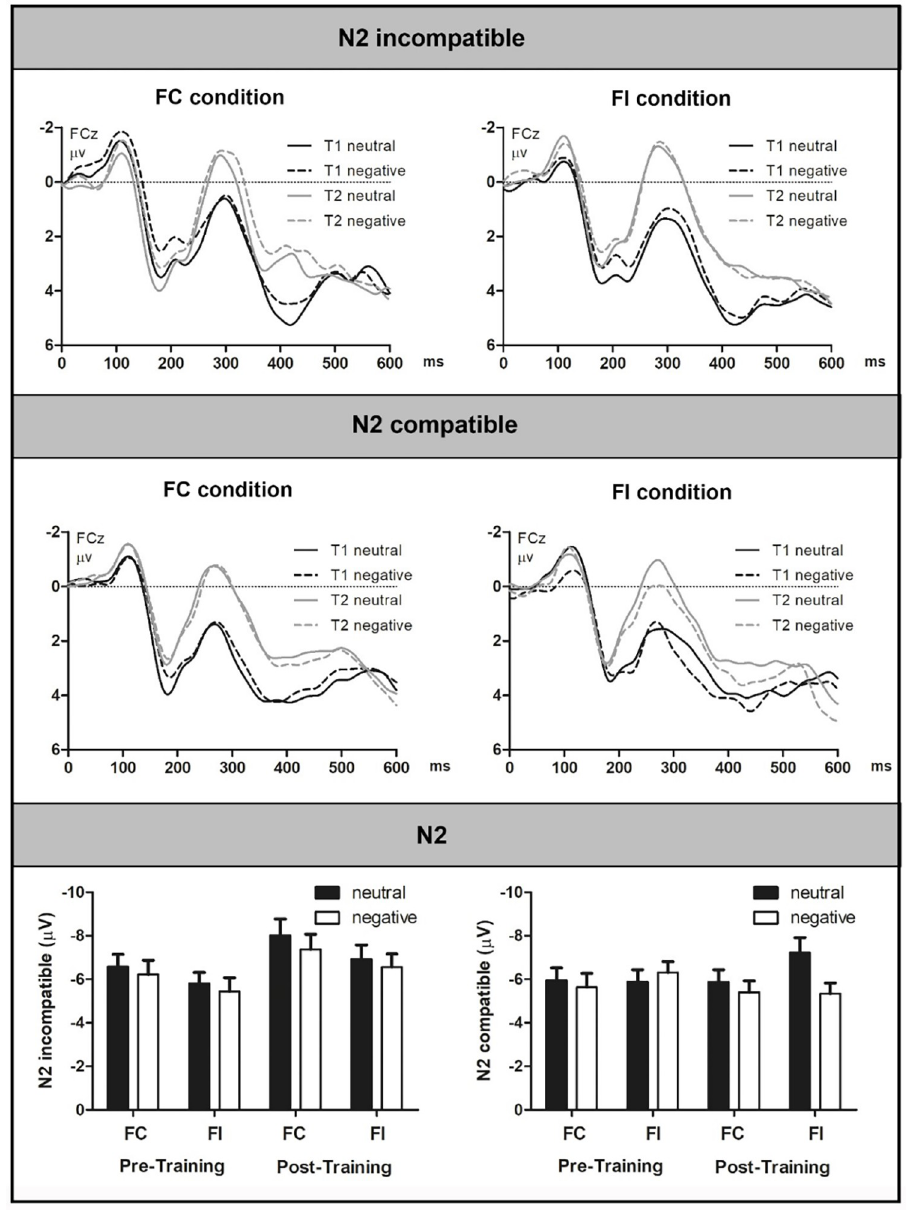
Fig 3. Grand Averages of the N2 in incompatible (upper panel) and compatible trials (middle panel) with neutral and negative pictures in the FC and FI condition at pre- (T1) and post-training (T2) at electrode FCz. The lower panel presents the CRN amplitude in each condition. Bars represent standard errors. FC = frequent compatible, FI = frequent incompatible. and picture type, F (1,23) = 6.63, p = .017, η p2 = .22, showed that this reduction was significantly stronger after training, t (23) = 4.44, p < .001, d = -0.84, 95% CI [-1.43, -0.25], than before training, t (23) = 0.84, p = .408. This effect was further specified by the three-way interactions time � compatibility � picture type, F (1,23) = 3.40, p = .078, η p2 = .13, and time � executive load � picture type, F (1,23) = 5.65, p = .026, η p2 = .20, and their four-way interaction time � execu- tive load � compatibility � picture type, F (1,23) = 8.51, p = .008, η p2 = .27. Generally, the